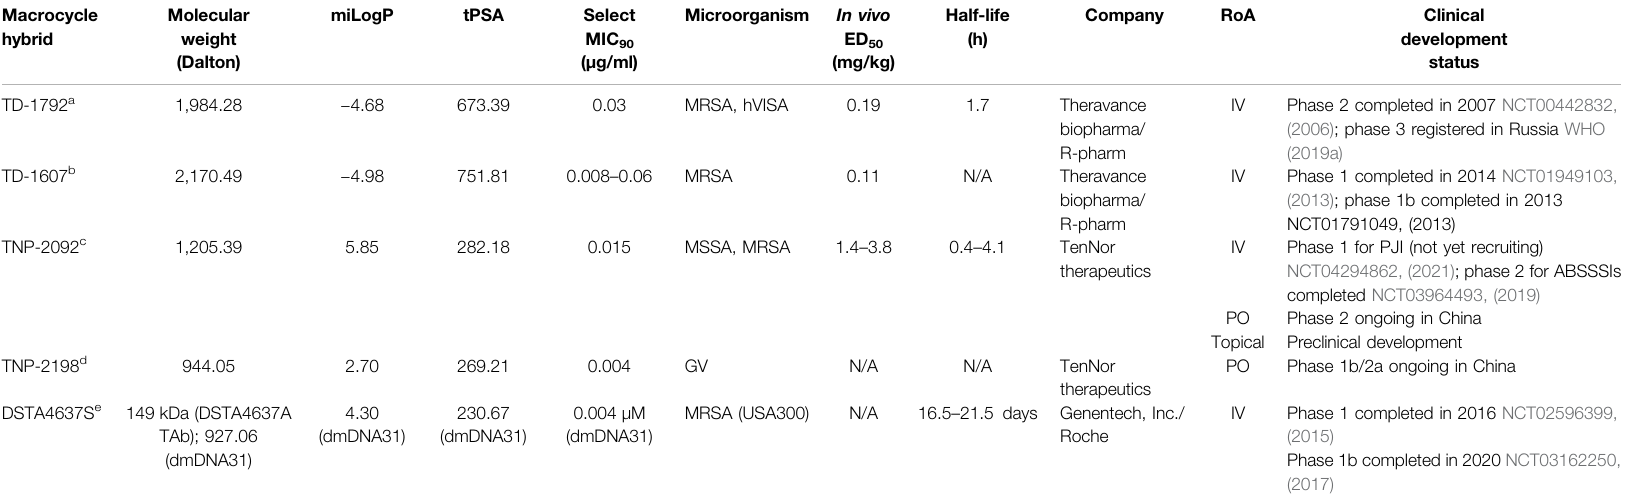
TABLE 1 | Overview and key parameters of clinical macrocycle – antibiotic